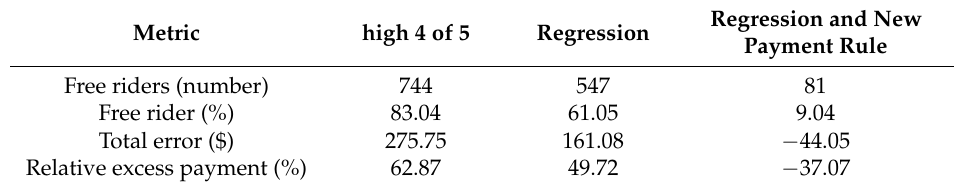
Table 7. Payment accuracy and scale of free riders for various CBL estimation and payment methods.